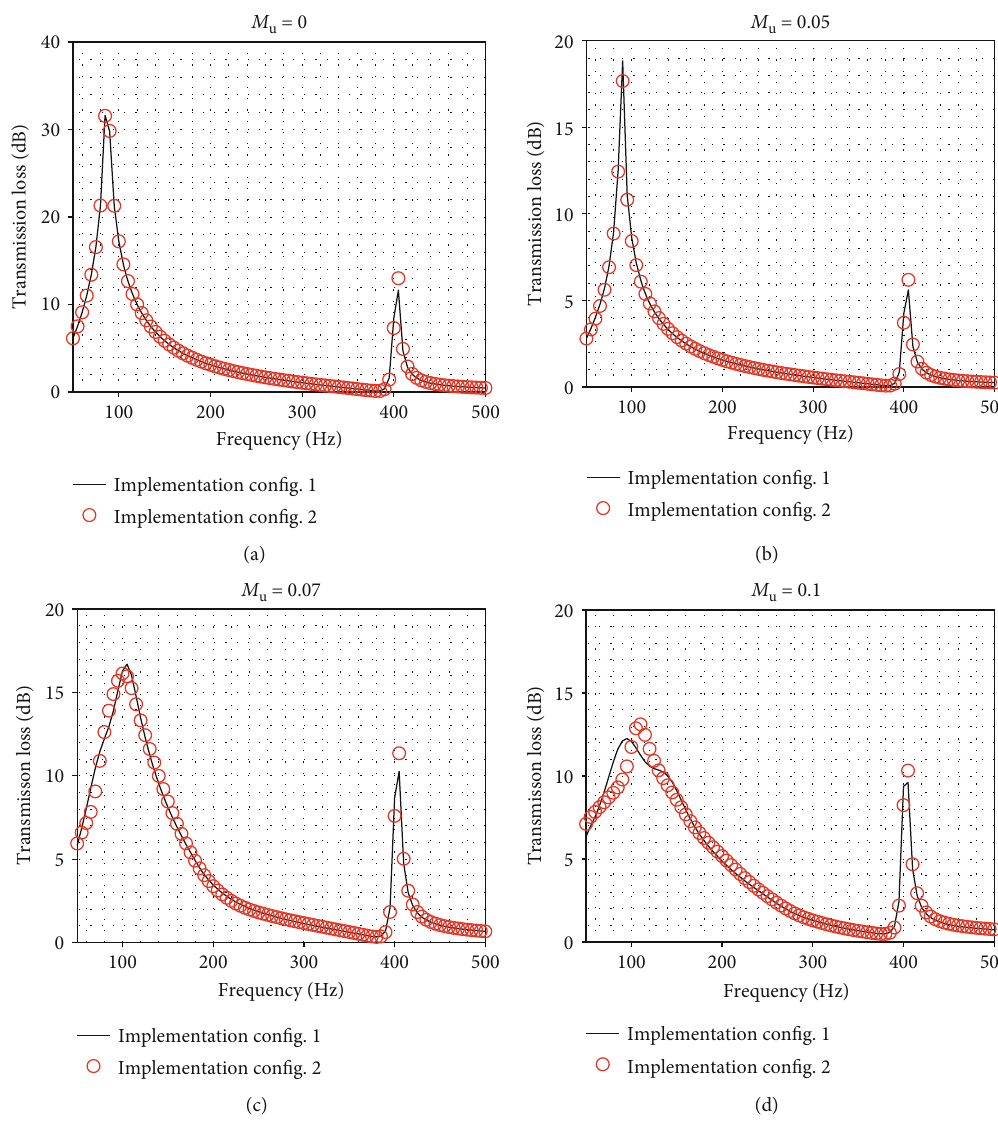
Figure 11: Comparison of the transmission loss performances of the modi fi ed Helmholtz resonator, as H ba ffl e is implemented in 2 di ff erent con fi gurations. (a) M